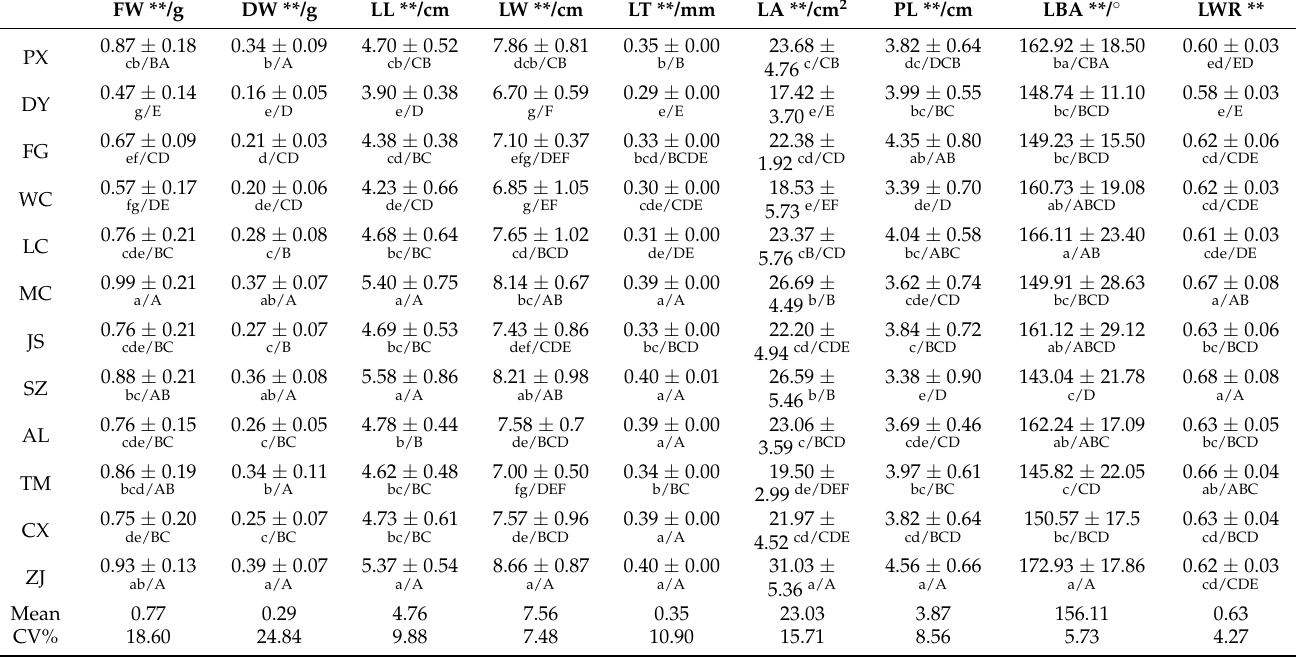
include fresh weight (FW), dry weight (DW), leaf length (LL), leaf width (LW), leaf thickness (LT), leaf area (LA), petiole length (PL), leaf base angle (LBA) and length:width ratio